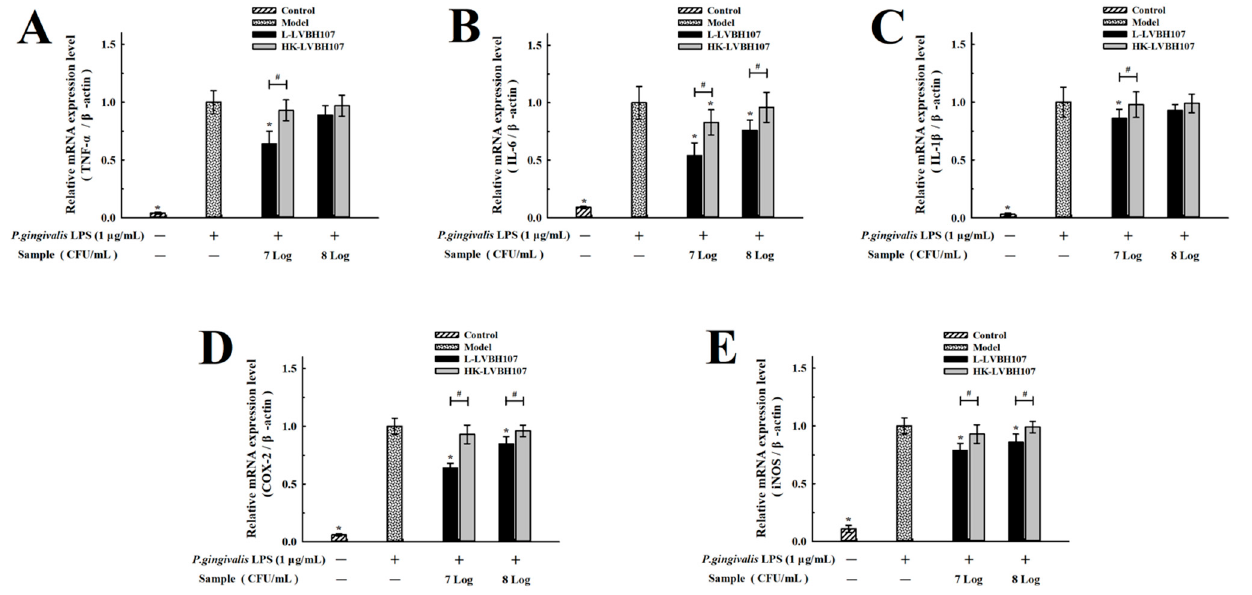
Figure 6. Effect of L. mesenteroides LVBH107 on mRNA expression in P. gingivalis LPS-stimulated RAW264.7 cells. RAW264.7 cells were treated with live or heat-killed L. mesenteroides LVBH107 and stimulated with P. gingivalis LPS for 24 h. Expressed mRNA levels of TNF- α ( A ), IL-6 ( B ), IL-1 β ( C ), COX-2 ( D ), and iNOS ( E ) were determined with relative quantification by normalization with β -actin. * p < 0.05, compared to P. gingivalis LPS group; # p < 0.05, comparison between live and heat-killed L. mesenteroides LVBH107. Actual p -values are shown in Table S8–S12.